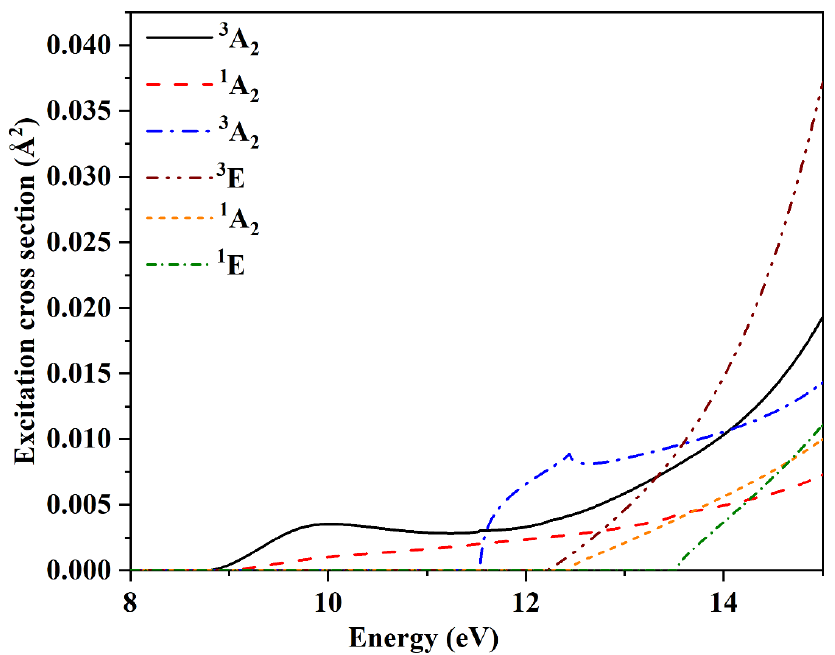
Figure 5. Electronic excitation cross-section from the ground state to the six low-lying excited states of c -C 4 F 8 scattering. of c -C 4 F 8